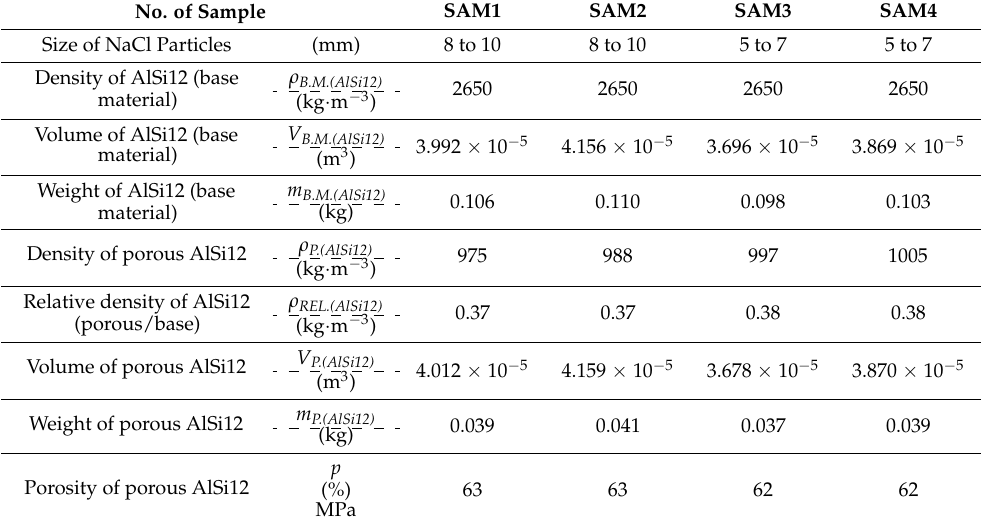
Table 5. Basic properties of base material and porous aluminium alloys (NaCl squeezed into alu- minium alloy melt)—samples SAM1–SAM4.